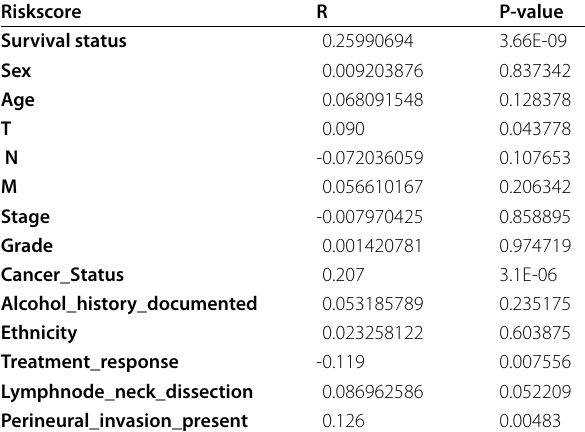
Table 4 The list of 19 genes related to OS of HNSCC in univariate Cox regression analysis